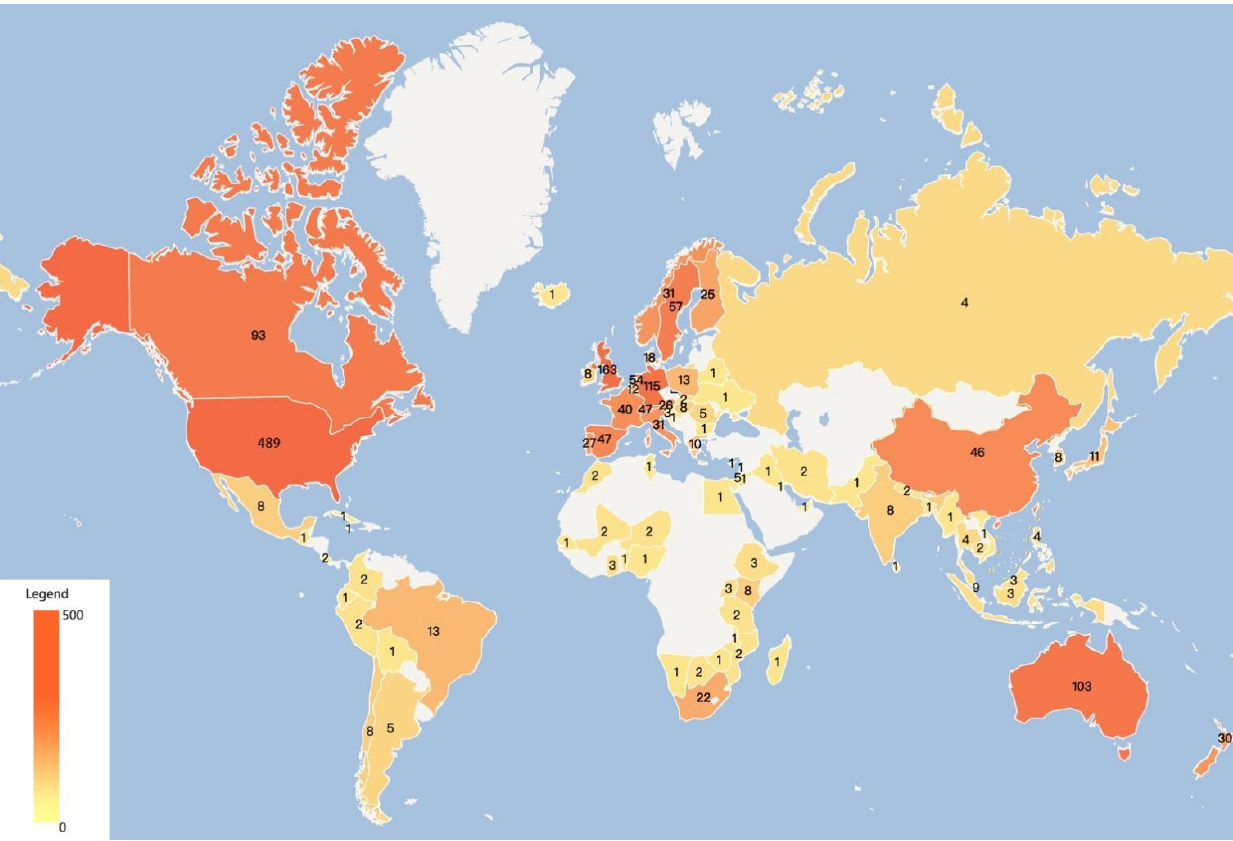
Figure 3. Geographical distribution of literature. Table 1. Top 20 countries in the number of articles published. No. Country/Region